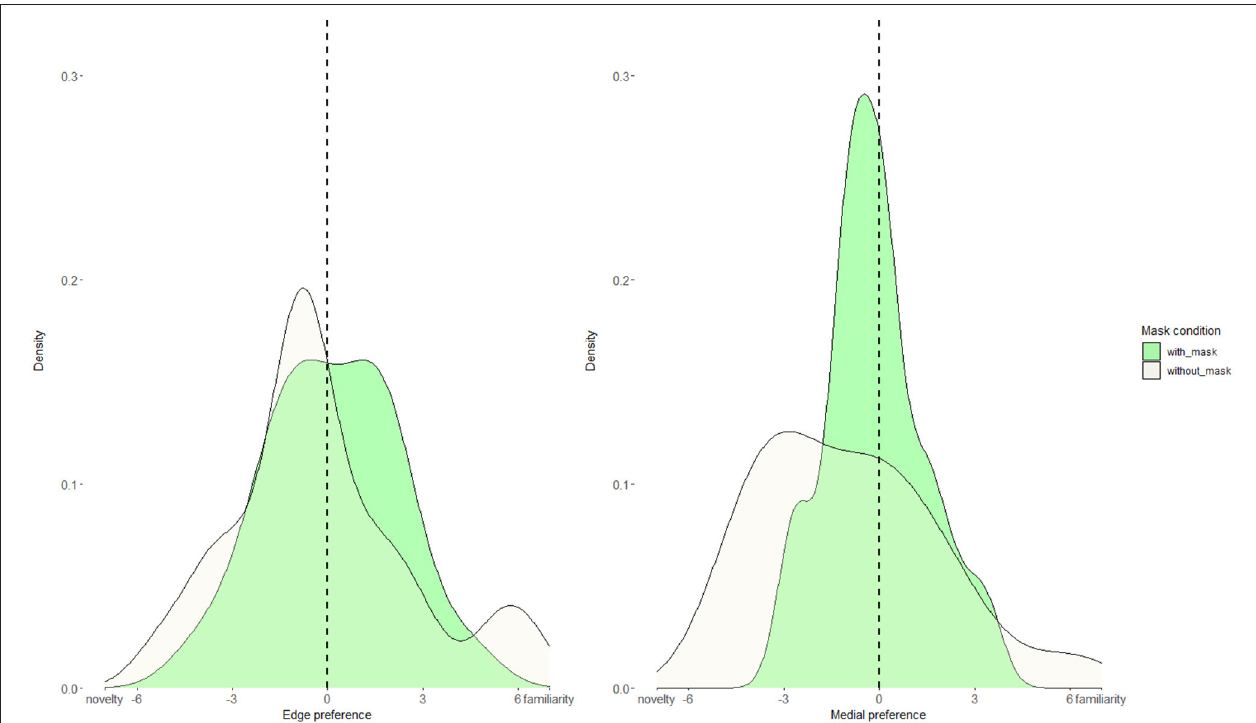
FIGURE 4 | Density distribution plots for edge and medial looking preferences in with-mask (green) and without-mask (beige) conditions. The dashed line represents no